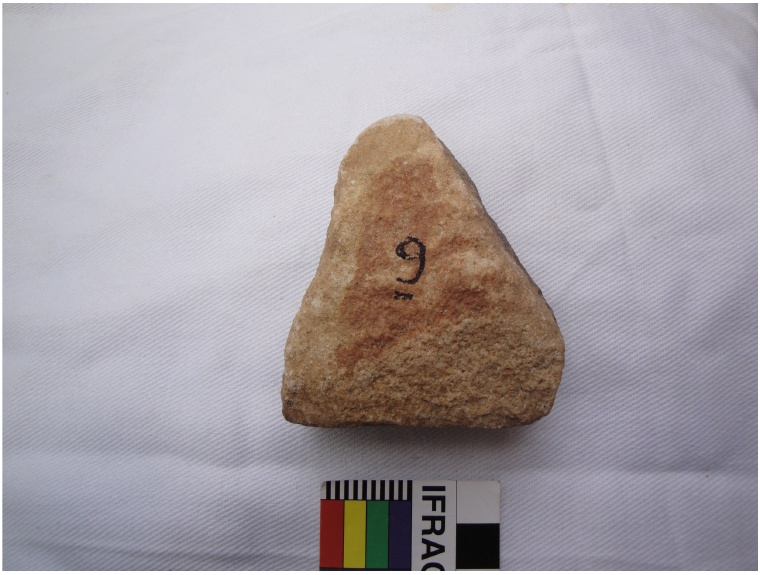
Figure 14. Hammer stone on hard quartzite cobble used for making